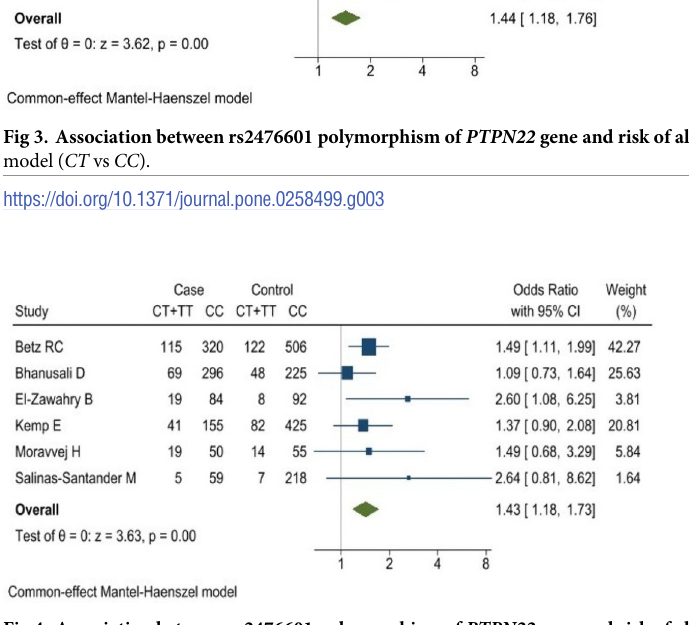
PLOS ONE | https://doi.org/10.1371/journal.pone.0258499 November4,